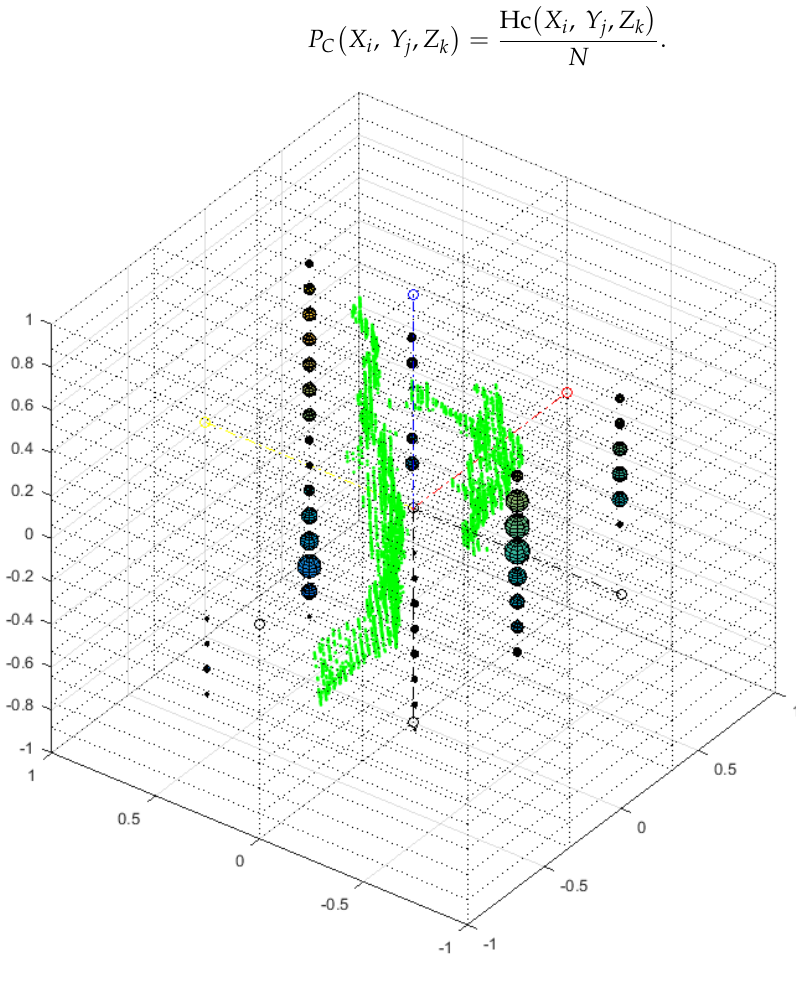
Figure 5. An MSL sign for the letter A, showing the Cartesian features in a 3D rectangular grid. The size of each sphere is proportional to the number of 3D cloud points in each sub-rectangular prism.